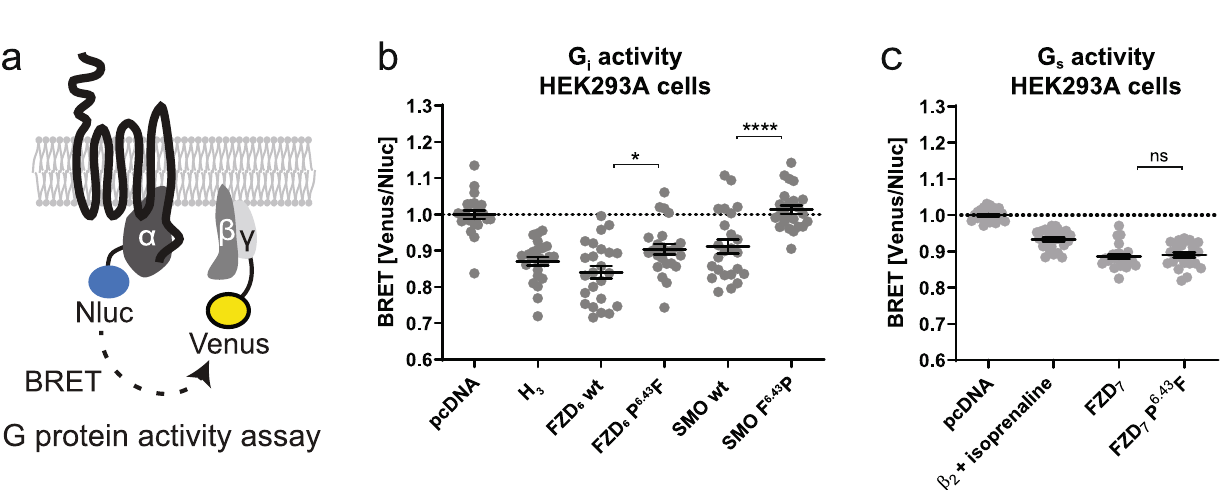
Fig. 2 BODIPY-cyclopamine binding and binding cavity volumes of FZD 6 and SMO. a Assay design schematic. b BODIPY-cyclopamine binding to FZD 6 and FZD 6 P 6.43 F (light and dark gray, respectively; left panel) and SMO and SMO F 6.43 P (light and dark violet, respectively; right panel) was assessed by the NanoBiT/BRET-binding assay. Saturation curves are presented as sigmoidal curves with logarithmic BODIPY-cyclopamine concentrations. Graphs present net NanoBRET values. Data points are presented as mean ± SEM from n = 4 for HiBiT-FZD 6 P 6.43 F and n = 5 individual experiments for the other receptor constructs. Curves for HiBiT-FZD 6 were fi t to a three parameter model. For HiBiT-SMO curves were fi t according to a four-parameter model. See Supplementary Fig. 6a – d for the cell-surface expression data of the HiBiT-receptor constructs. Source data are provided as a Source Data fi le. c The 7TM binding cavity of FZD 6 and SMO wild-type (upper panels) and P 6.43 F and F 6.43 P mutants (lower panels). The pink grid represents the locations of the Voronoi vertices at isovalue 3 (i.e., the location of the followed cavity in the protein structure) throughout the MD simulation trajectories. The receptors (the last frame of each system after 500 ns of simulation) are shown as cartoon and the aromatic interaction network (marked by pink arrows) as sticks. Color code is as follows: white cartoon: FZD 6 , gray cartoon: FZD 6 P 6.43 F, light violet cartoon: SMO, dark violet cartoon: SMO F 6.43 P, violet sticks: carbon, red sticks: oxygen, blue sticks: nitrogen. Note that for visualization purposes the binding cavity grid is projected on top of the protein structures. d The binding cavity volumes of each studied system (left). The median is marked as black line. The cavity volumes as function of time (right). The replicas are plotted as a continuous trajectory (replica 1: 0 – 500 ns; replica 2: 500 – 750 ns; replica 3: 750 – 1000 ns; replica 4: 1000 – 1250 ns). The color code follows that of panel c .